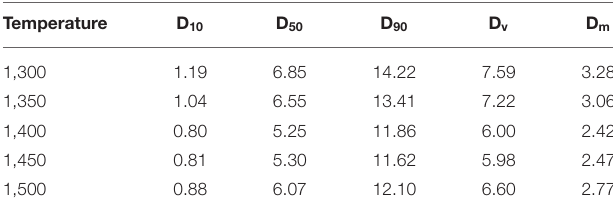
TABLE 1 | The particle parameters of alumina powder thermally treated under different temperatures measured by laser particle size analysis ( µ m).